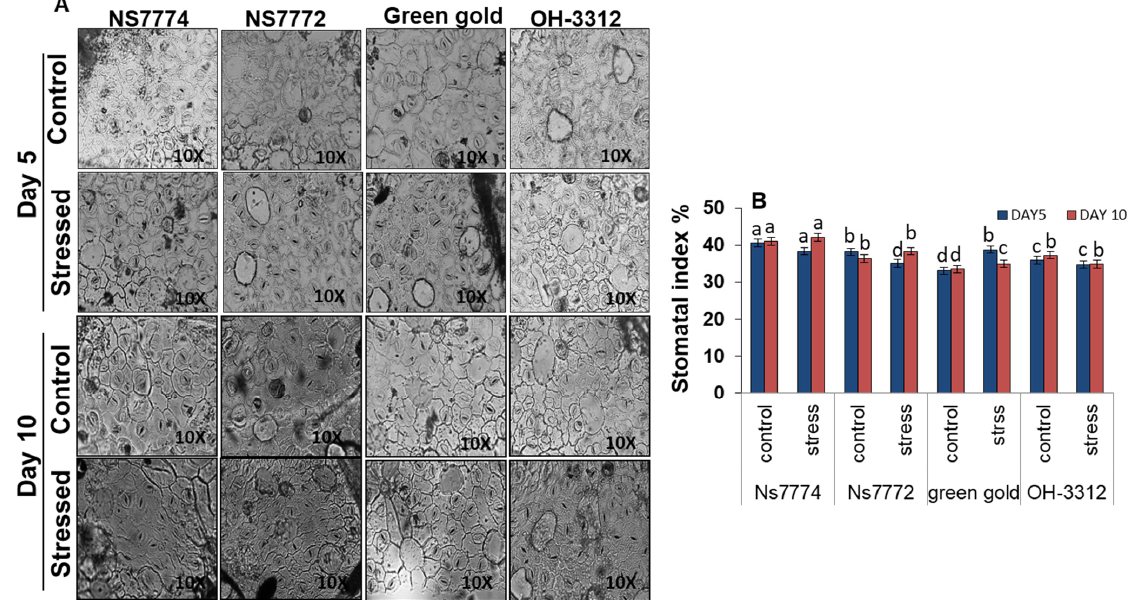
Figure 9. ( A ) Representative image of stomata, and ( B ) stomatal index, as affected by drought stress at 5 and 10 days of interval in okra genotypes NS7774, NS7772, Green Gold, and OH3312, along with respective controls at 10X magnification. Vertical bars indicate mean ± SE for n = 5. Means denoted by the different letter are significantly different at p ≤ 0.05 according to the Tukey’s studentized range test.